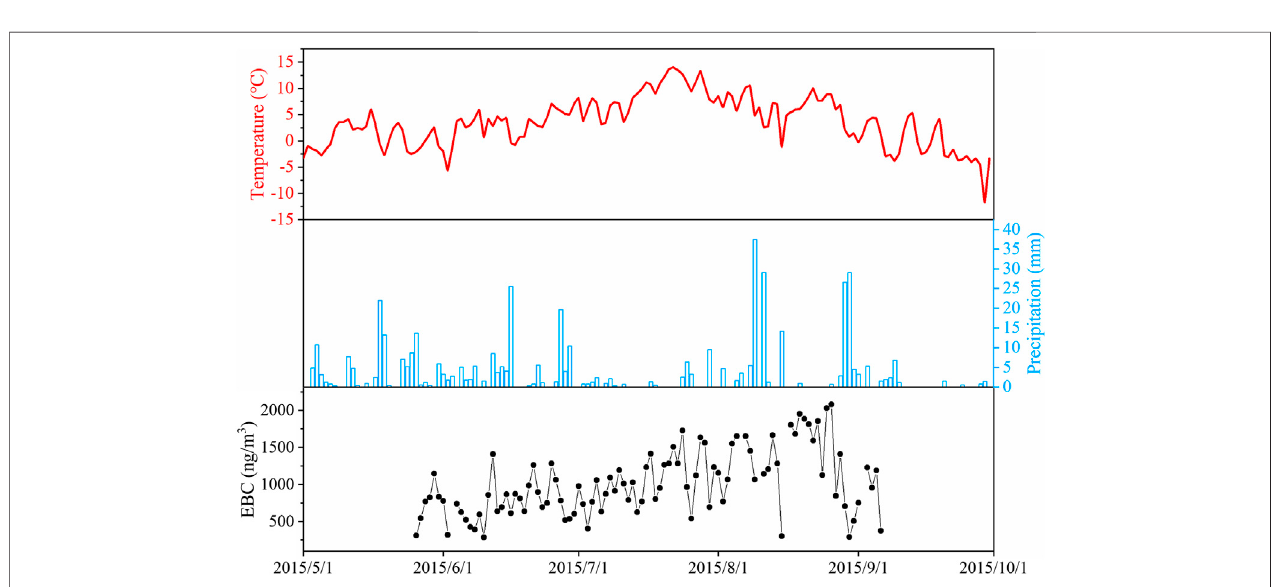
FIGURE 2 | Time series of daily-averaged temperature, precipitation, and equivalent black carbon (EBC) concentrations. EBC data came from the Tian Shan Glacier Station (43 ° 12 ′ N, 87 ° 07 ′ E, 2,100 m), about 30 km northeast of Urumqi Glacier No.1.